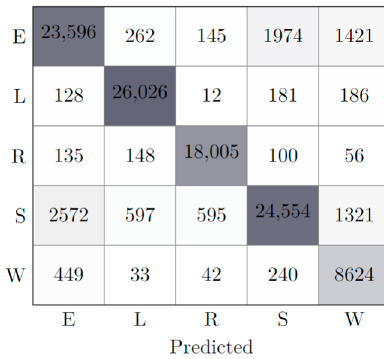
Table 7. Scores of best model (InertFeatures + TMP).